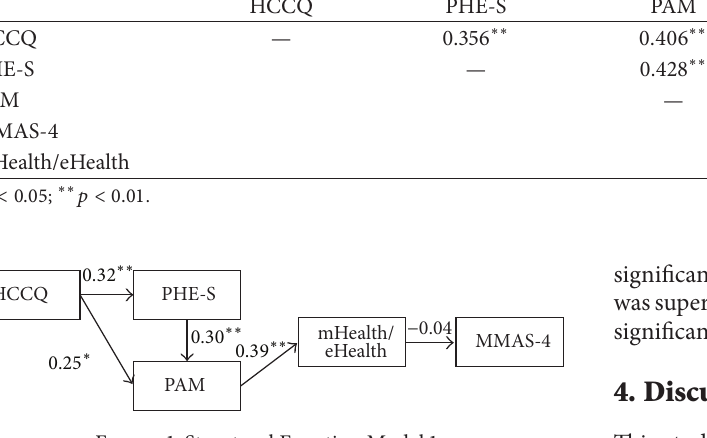
Figure 1: Structural Equation Model 1.